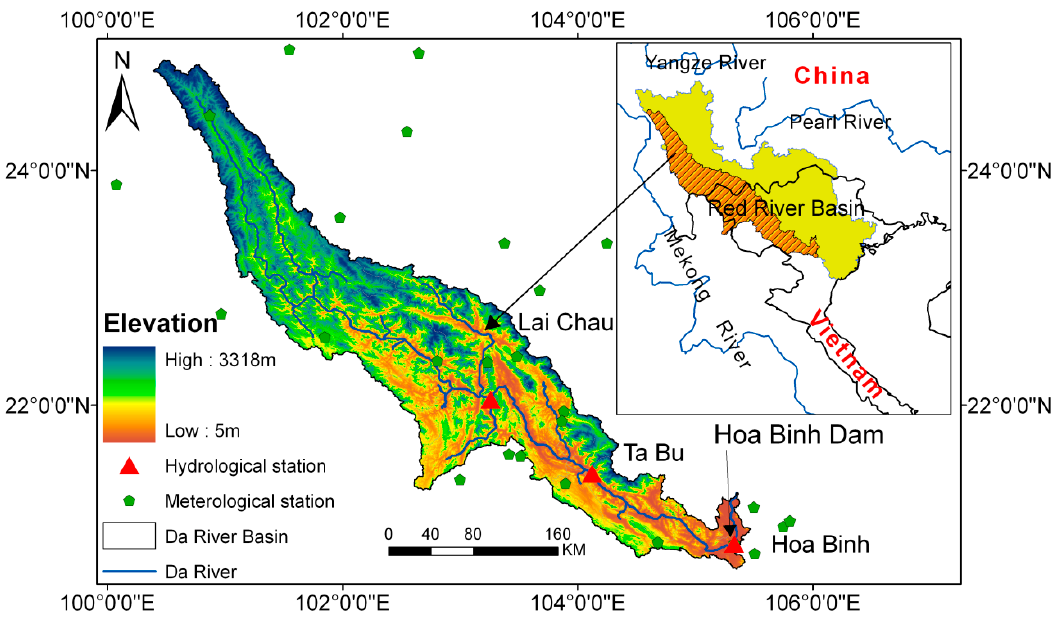
Figure 1. Location of the Da River Basin (DRB) and the hydro-meteorological stations .